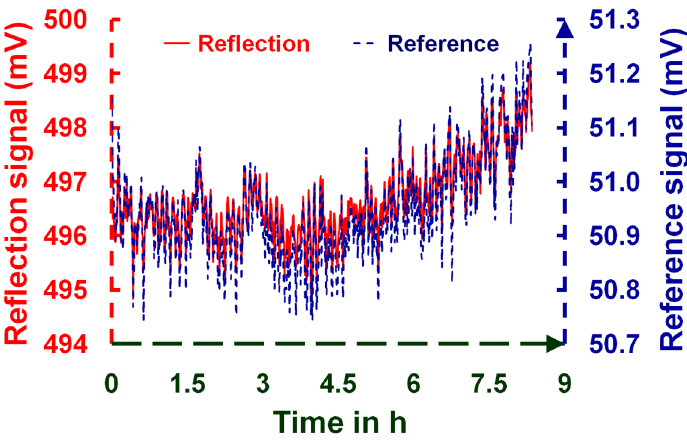
Figure 7. Laser fluctuations measured on both channels over 9 h.